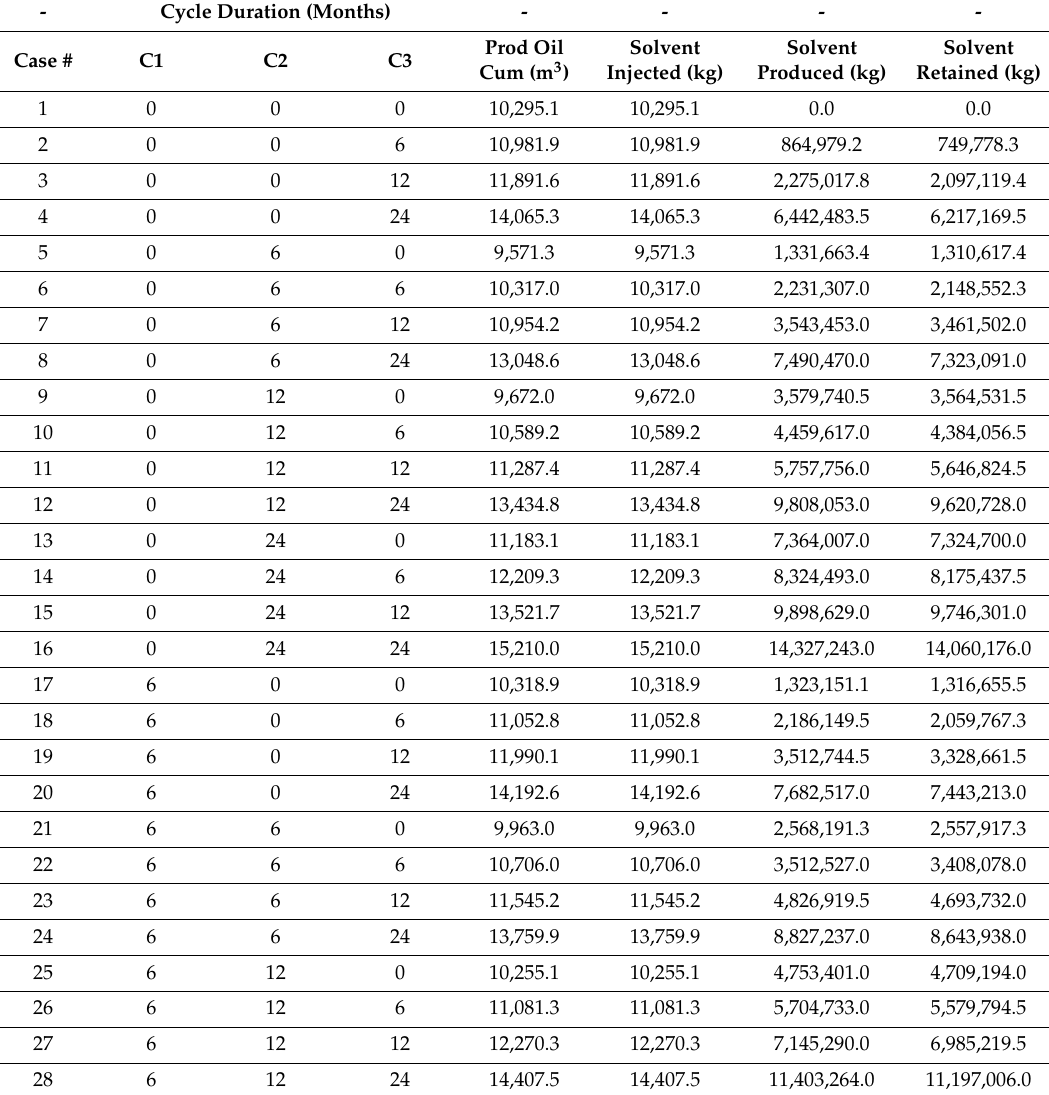
Table A1. Cumulative oil production and solvent retained for cyclic ES-SAGD cases with hexane at 10% mole and di ff erent cycle’s